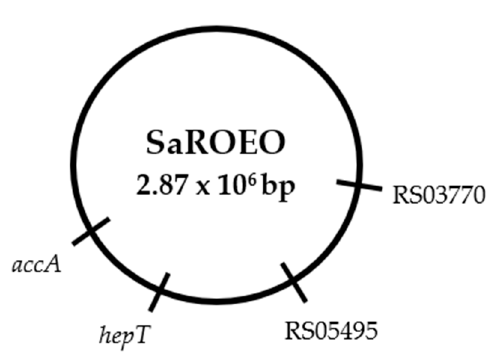
Figure 4. Genomic map of evolved strain (SaROEO) in comparison with Staphylococcus aureus USA300 (SaWT).